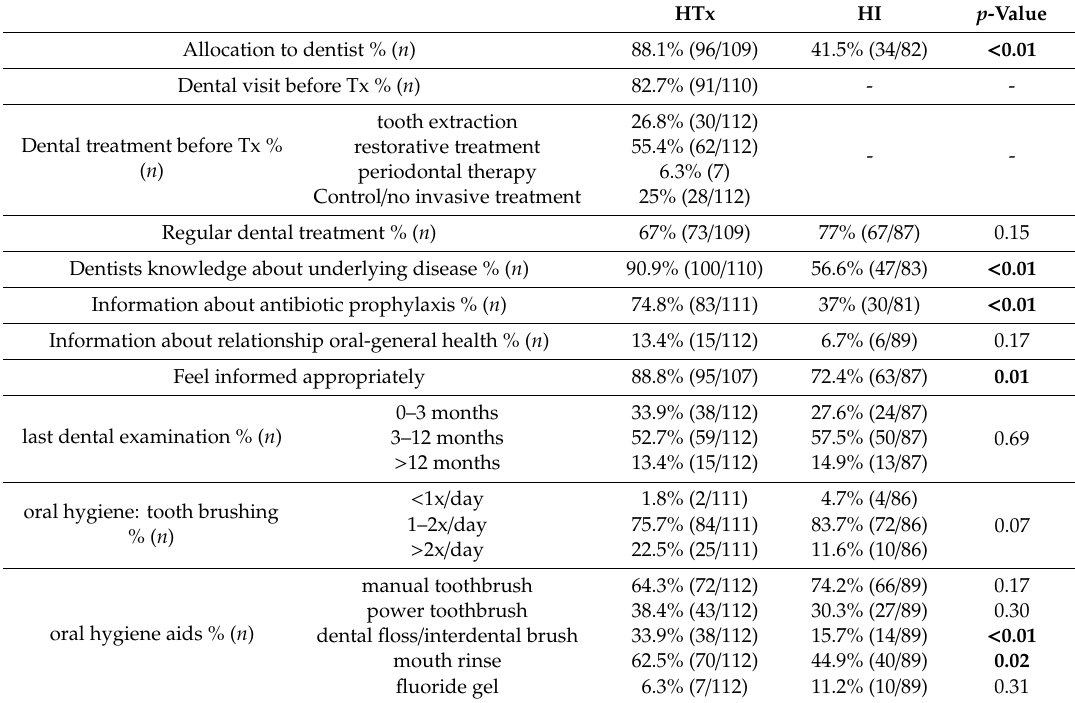
Table 2. Results of the dental behaviour between groups, significance level: p < 0.05.